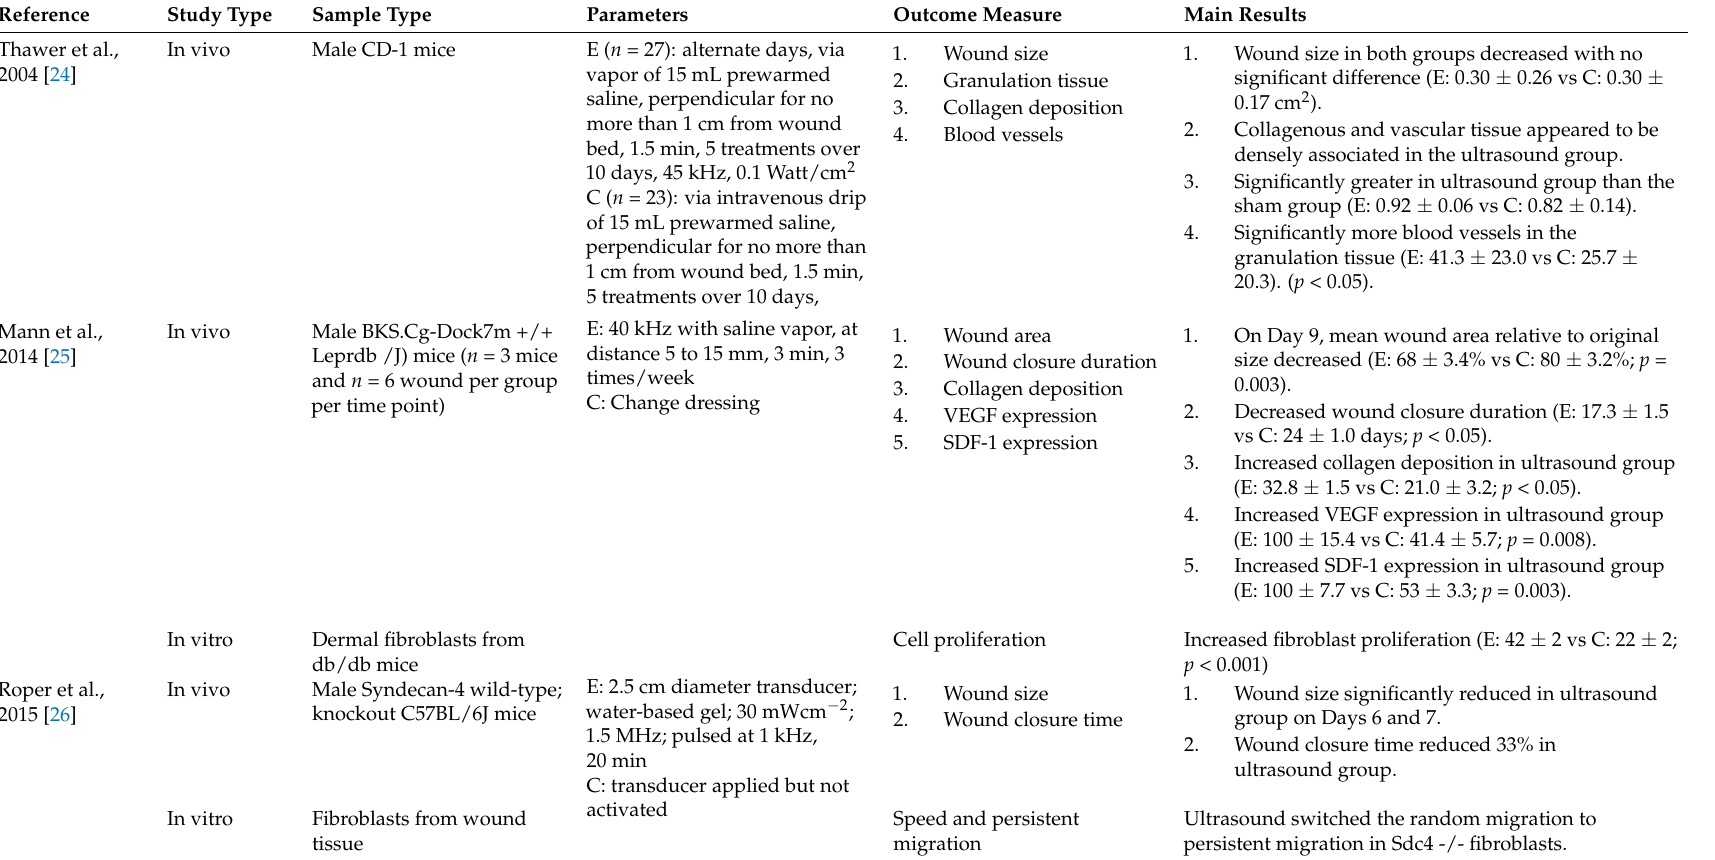
Table 2. Outcomes of US energy for treating diabetic